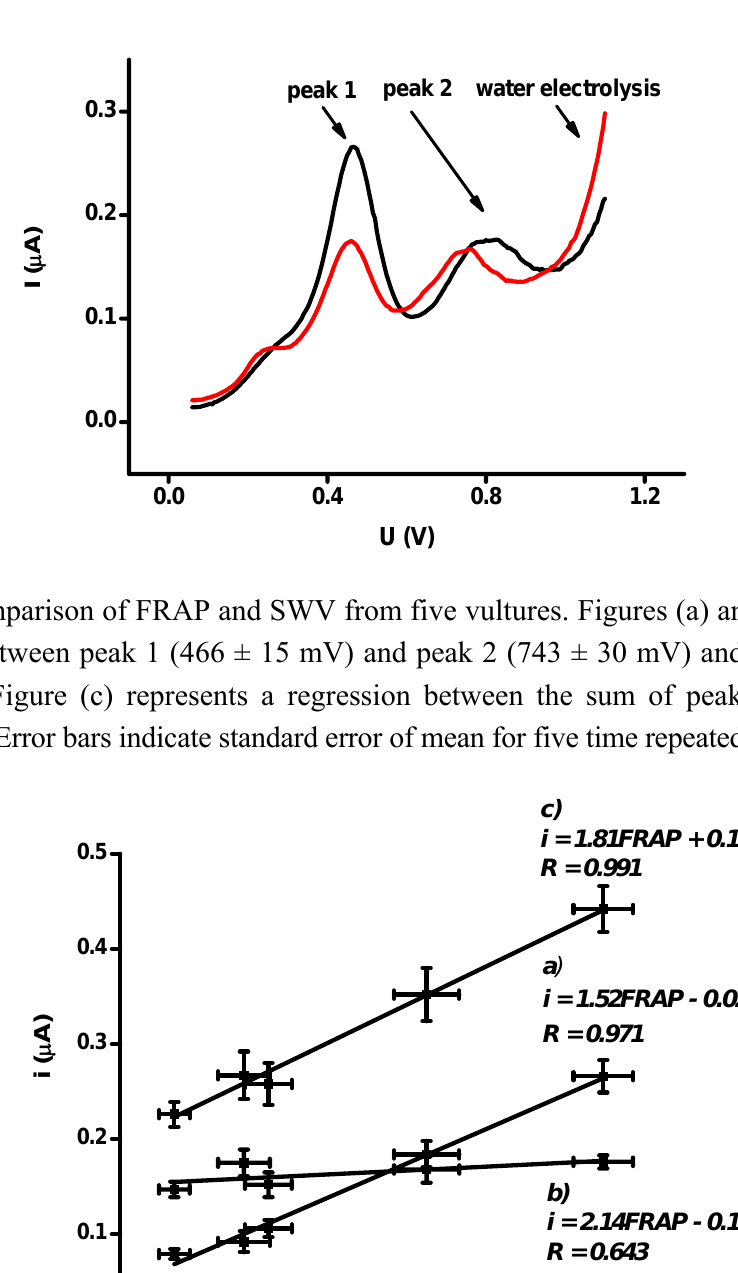
Figure 1. Voltammograms of vultures’ plasma samples. Peak 1 (466 ± 15 mV), peak 2 (743 ± 30 mV) as well as water electrolysis region are indicated by arrows. The voltammogram depicted by black line was achieved by assay of the plasma sample with the FRAP value of 1,850 μ mol/L, the red line indicates the plasma samle with the FRAP level of 1,350 μ mol/L.